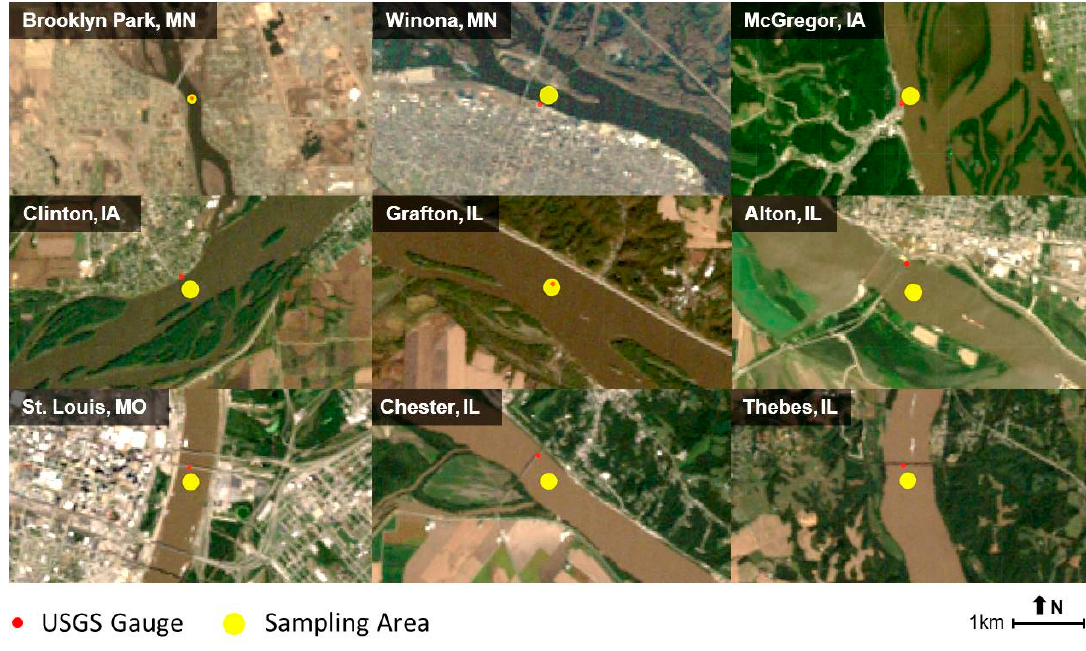
Figure 4. Sampling areas for Landsat surface reflectance retrieval at the study sites.